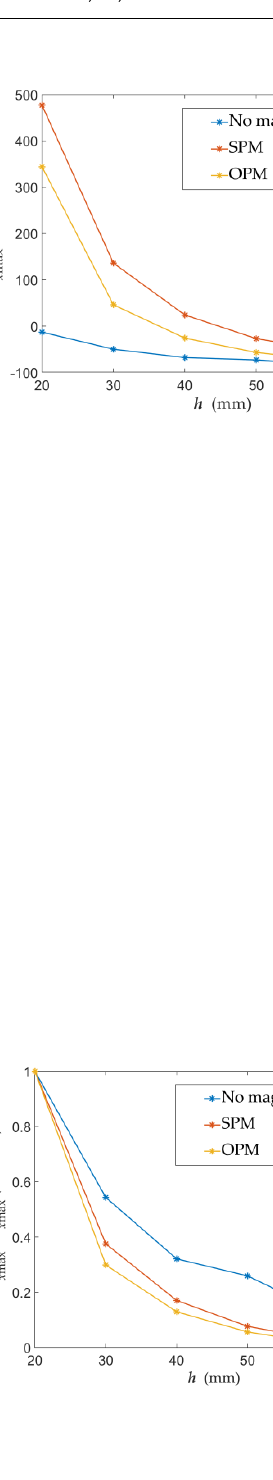
Figure 20. Graphs of the normalized value of the magnetic field component B x ( x ) as a function of the concrete cover thickness h (mm) obtained for various magnetization methods.